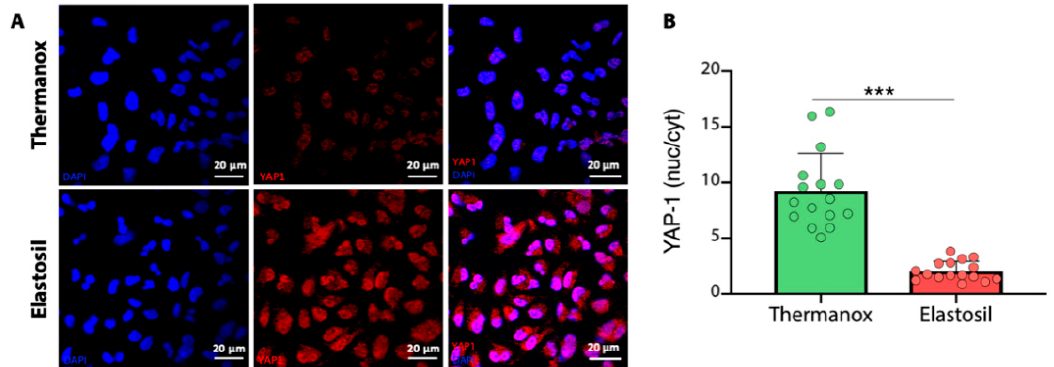
Figure 6. ( A ) Immunofluorescence images of A549 cells stained for YAP-1 (red) cultured on Thermanox™ Coverslips (first row) and on Elastosil ® Film (second row). Nuclei are stained in blue. Merged images are shown on the right. Magnification 63 × ( B ) Percentage of nuclear YAP-1 in A549 cells cultured on Thermanox™ Coverslips or Elastosil ® Film (*** p < 0.001, n =